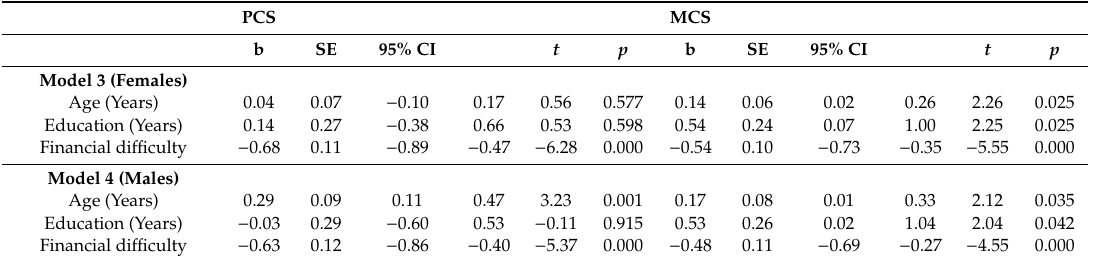
Table 4. Summary of linear regressions with PCS and MCS as the outcomes by gender. PCS MCS b